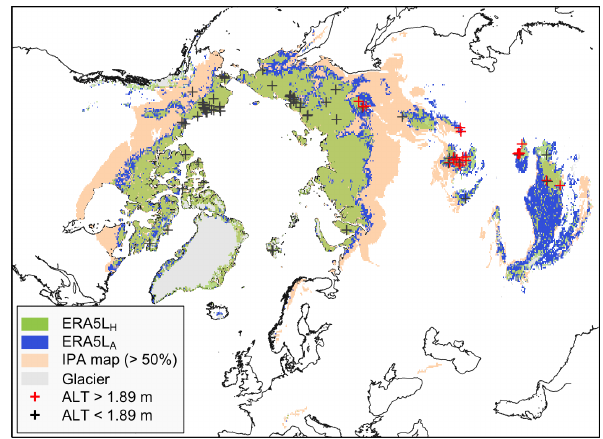
Figure 5. Near-surface permafrost area in 2002 derived from hourly (ERA5L H ) and annual (ERA5L A ) ERA5L soil temperature over- lapping the continuous and discontinuous permafrost zones (per- mafrost extent > 50%) of the IPA map. Active-layer thicknesses taken from Peng et al.